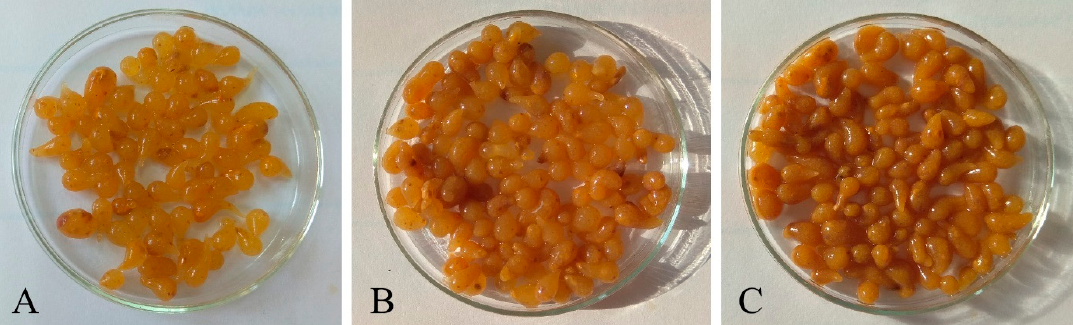
Figure 2. Beebread caviar in various proportions of the taste base to the carrier: ( A )—1:4, ( B )—1:2, ( C )—1:1 .